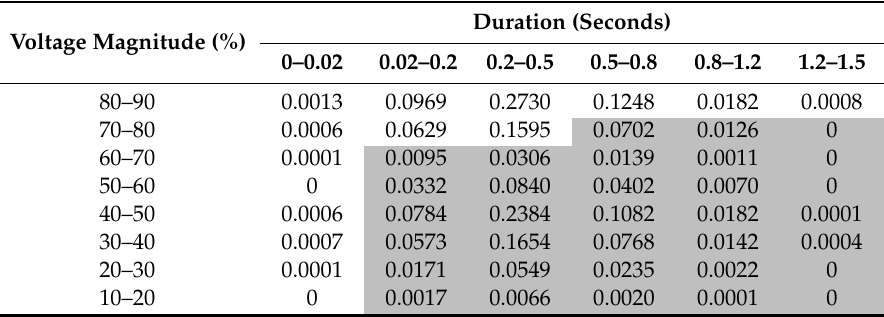
Table 2. SD for load point 1.